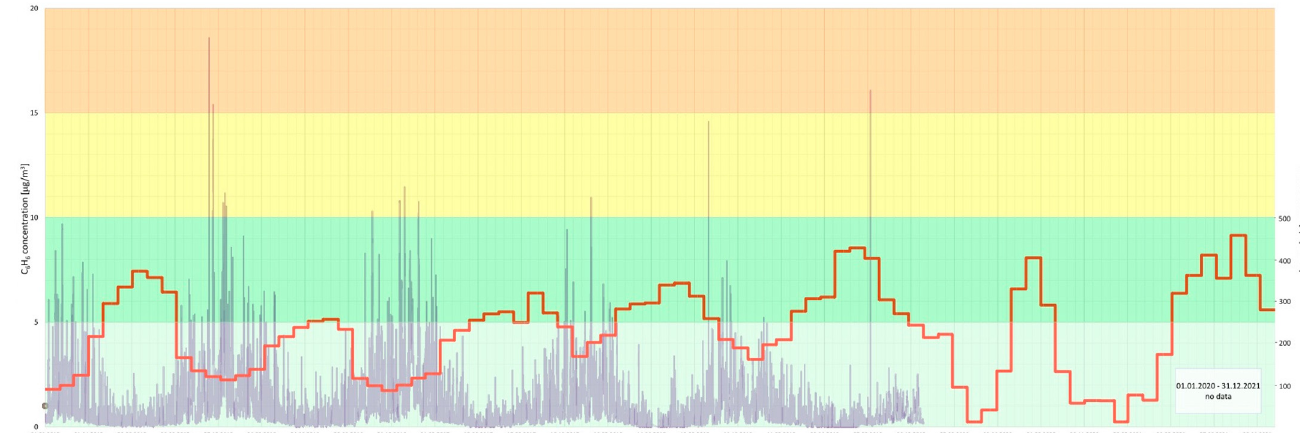
Figure 7. C 6 H 6 concentration in relation to tourist traffic (the Gda ń sk agglomeration, years 2015–2021). Source: own study.